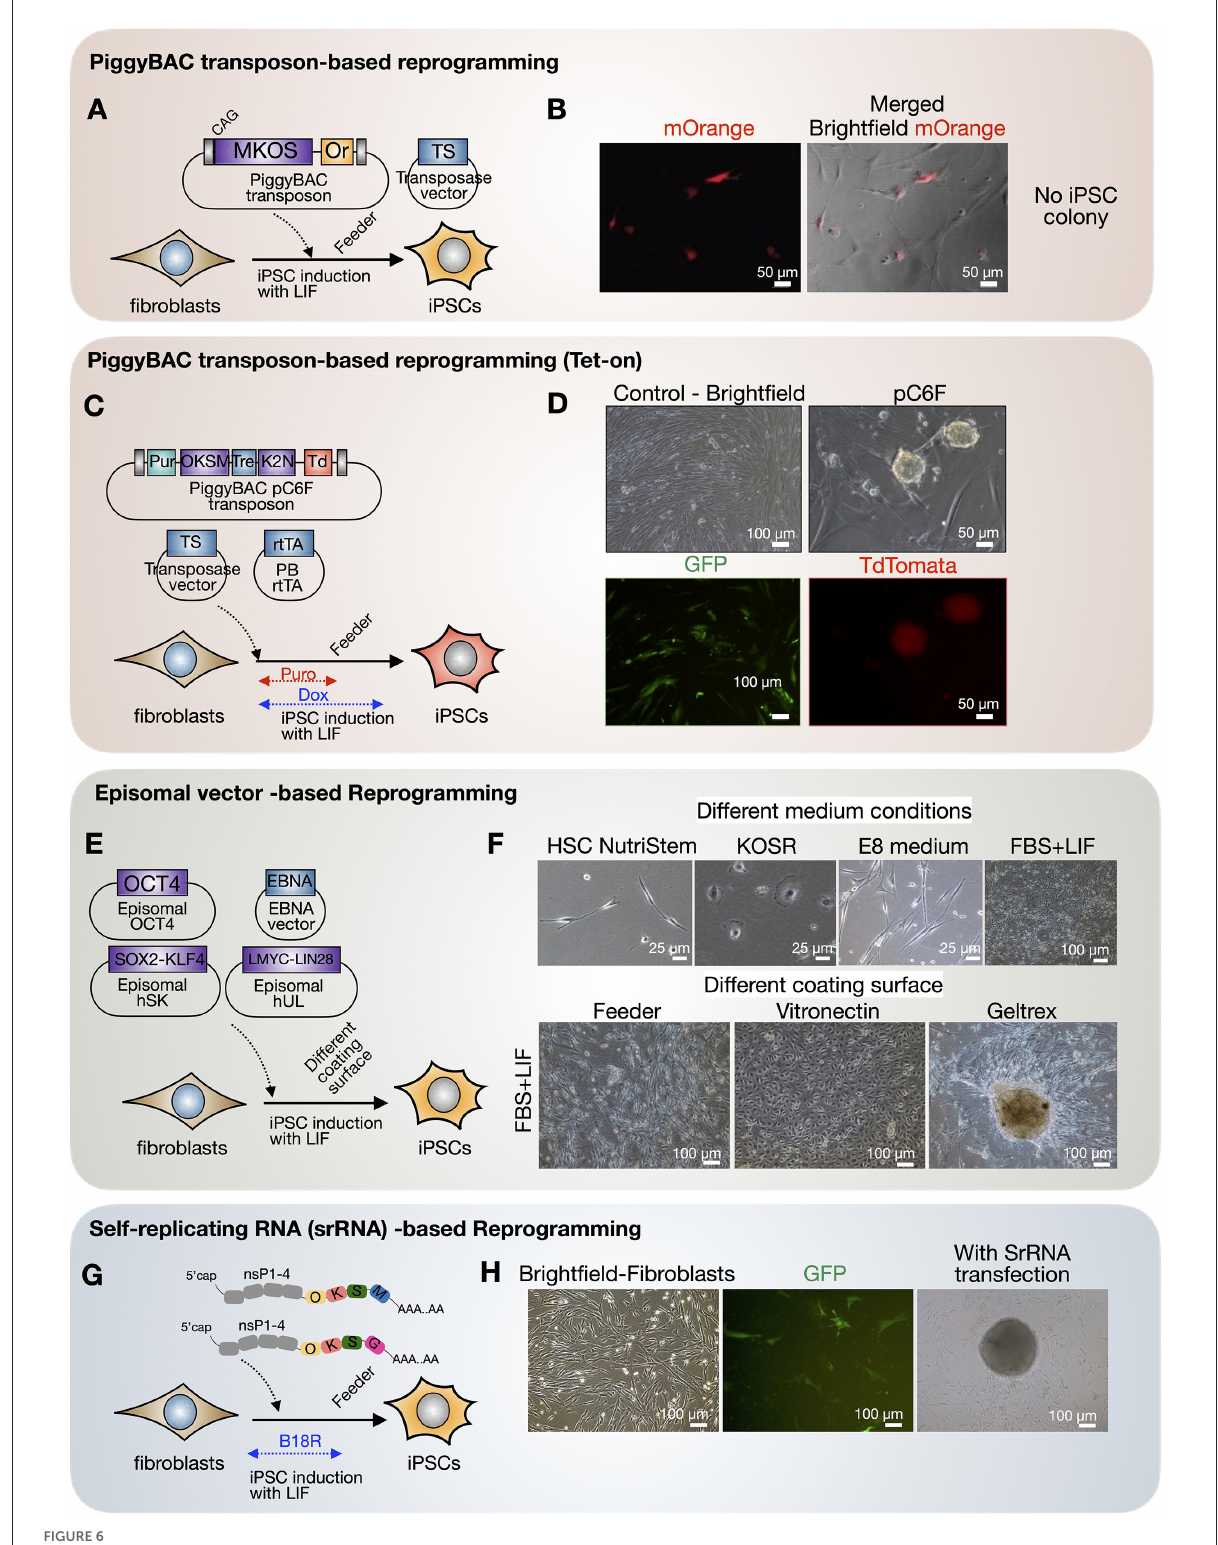
FIGURE6 Cellular reprogramming of fishing cat cells via different virus-free approaches. (A,B) Fishing cat fibroblasts were reprogrammed with PiggyBAC transposon carrying mouse C-Myc, Klf4, Oct4, and Sox2 (MKOS) and mOrange (Or) as a reporter, together with an expression vector